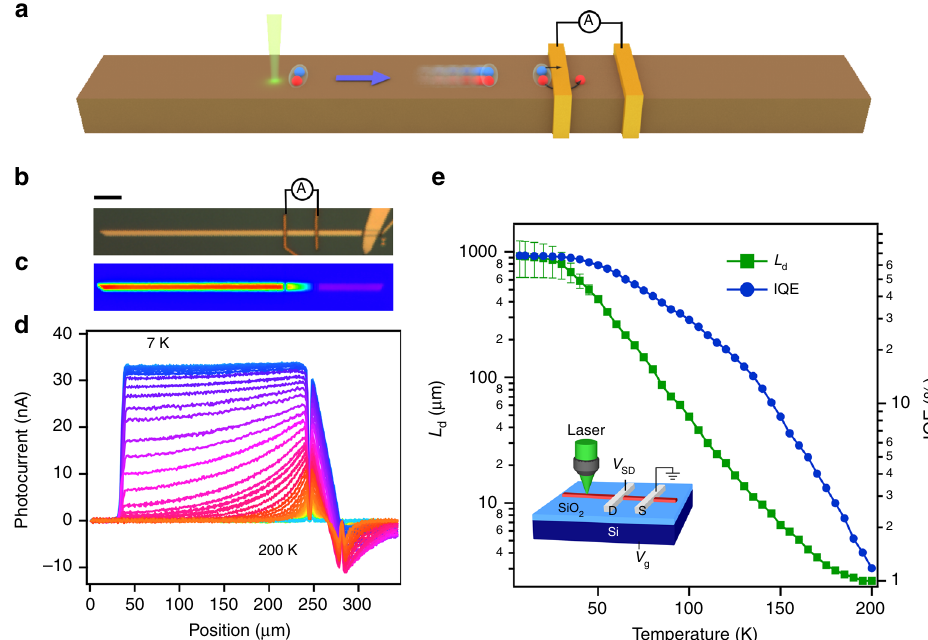
Fig. 1 Non-local photocurrent generation in a TI nanoribbon. a Schematic of exciton transport in TIs. Electrons and holes, denoted by blue and red balls, respectively, are bound and travel ballistically at TI surface until being separated at the metal contact. b Optical image of a Sb-doped Bi 2 Se 3 nanoribbon (305 × 6.5 × 0.13 μ m 3 ) in contact with Cr/Au electrodes. The far right end of the nanoribbon is in contact with another TI nanoplate. The scale bar denotes 30 μ m. c A photocurrent map collected by scanning a focused laser at normal incidence at 7 K and zero source – drain and gate biases. Laser power is 166 nW. d Photocurrent distributions along the nanoribbon axis at various temperatures. e L d and IQE as a function of temperature. IQE (electron collected per absorbed photon) is calculated from the photocurrent and laser power considering a re fl ectance of 30%. The uncertainty of L d becomes large at low temperature because L d is several times larger than L . Inset: SPCM